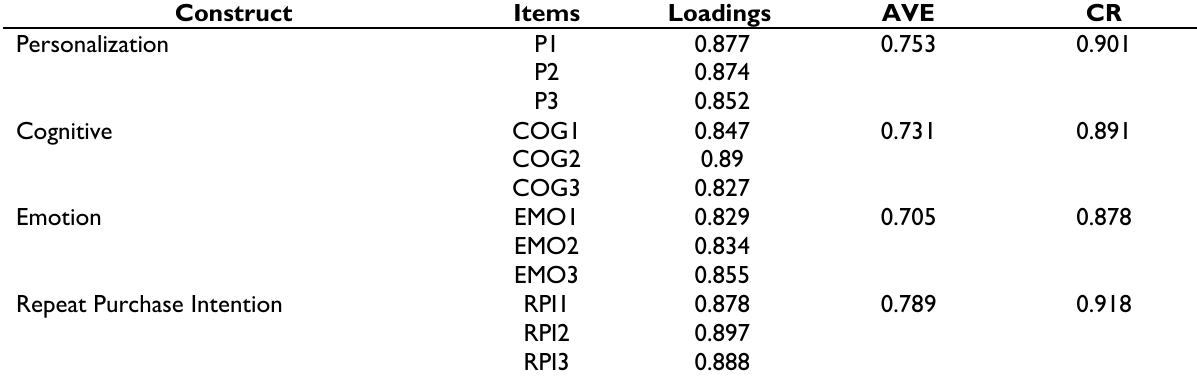
Table 2. Results of the measurement model